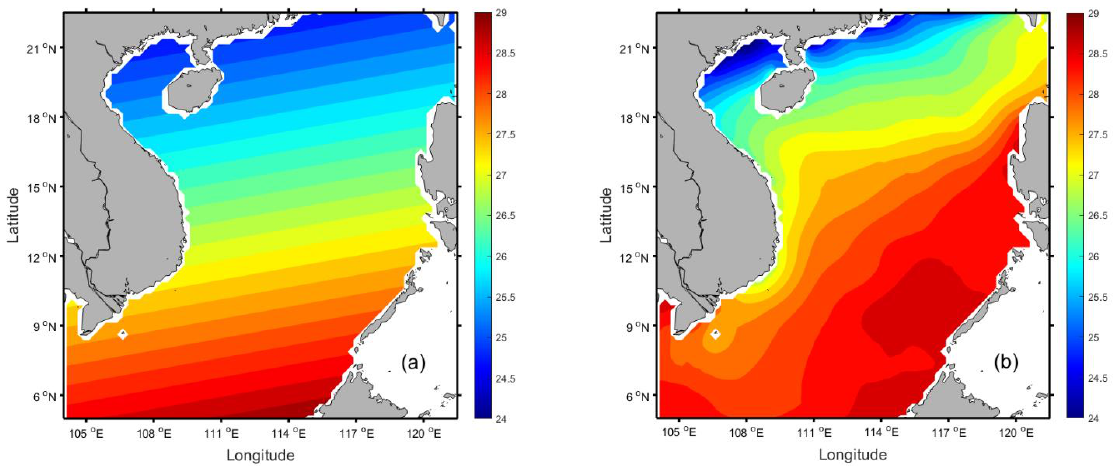
Figure 2. Given SST distribution I ( a ) and II ( b ) (unit: °C).